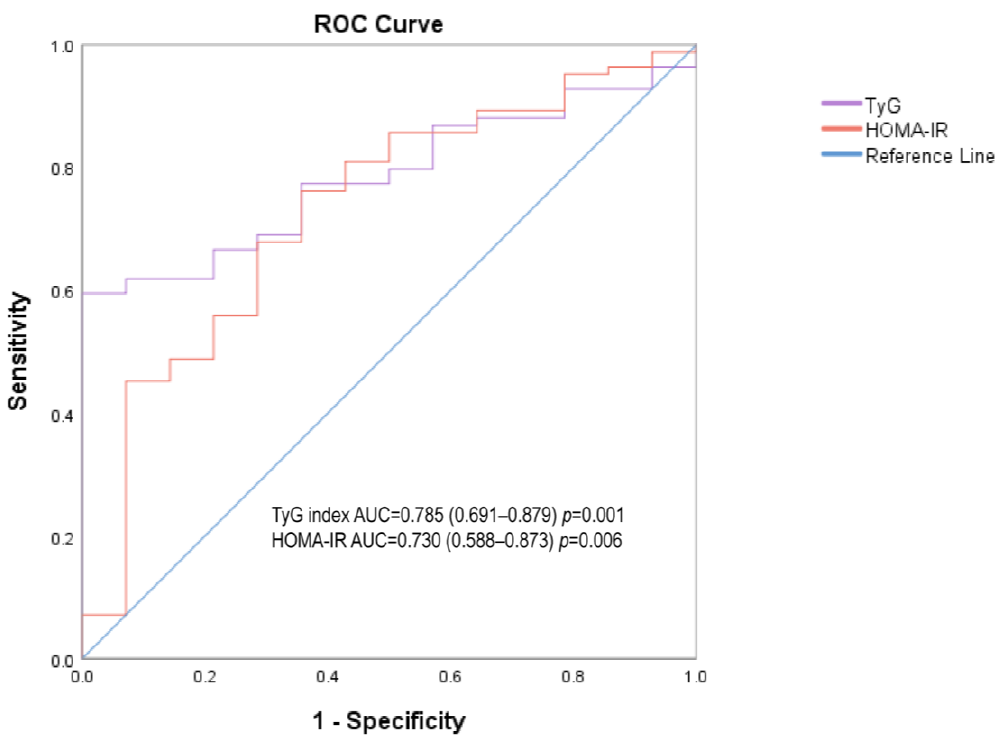
Figure 3. Receiver operating characteristic (ROC) analysis for TyG index and HOMA-IR in the identification of insulin resistance.